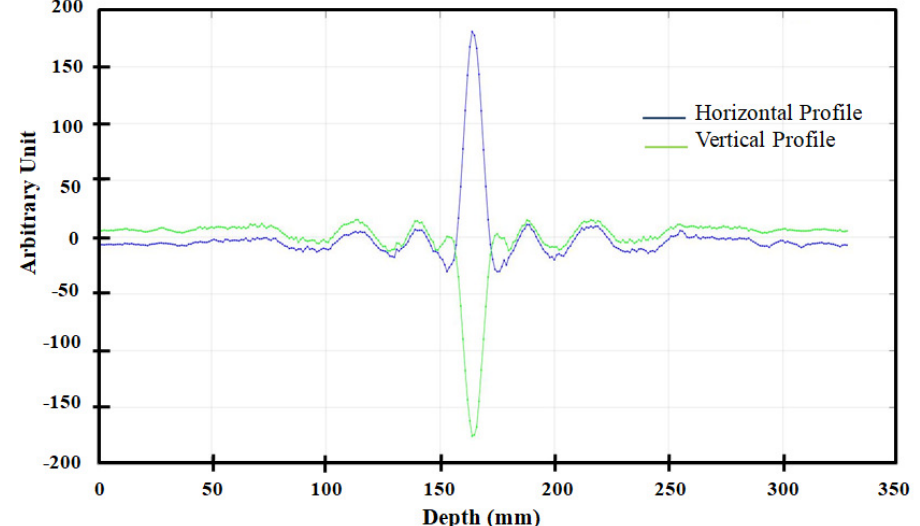
Figure 6. Horizontal and vertical profiles for decoded image of the studied case: location 17 and TBR =